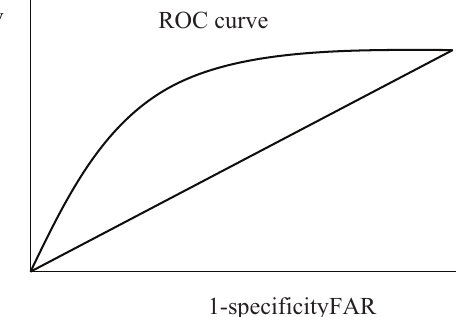
ROC curve Sensitivity Figure 1. ROC for tenure choices